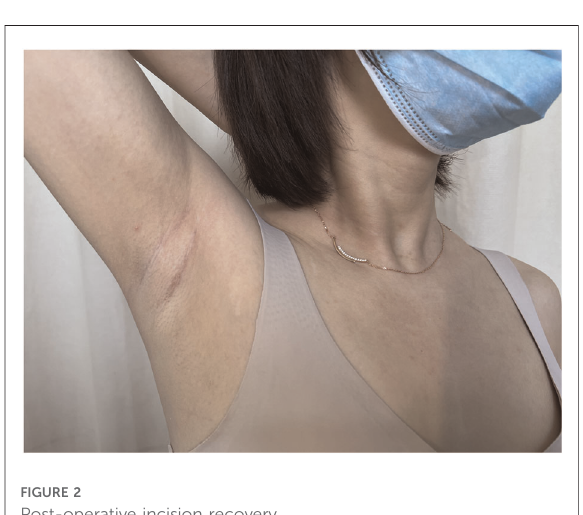
FIGURE 2 Post-operative incision